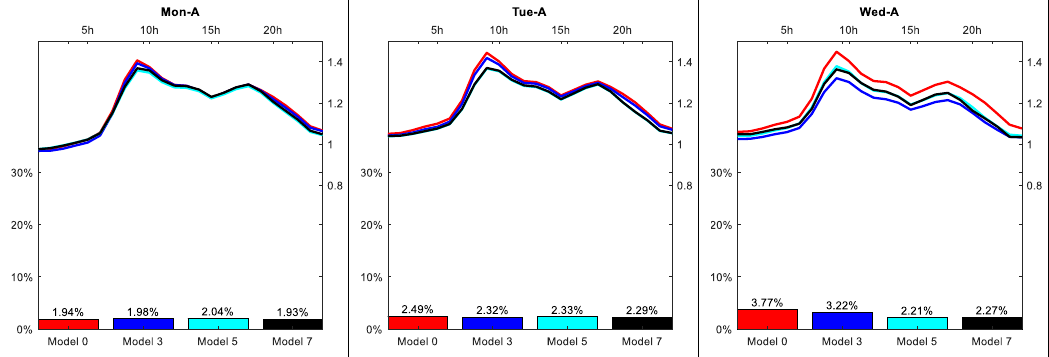
Figure A2. Special days type 1 and 2.